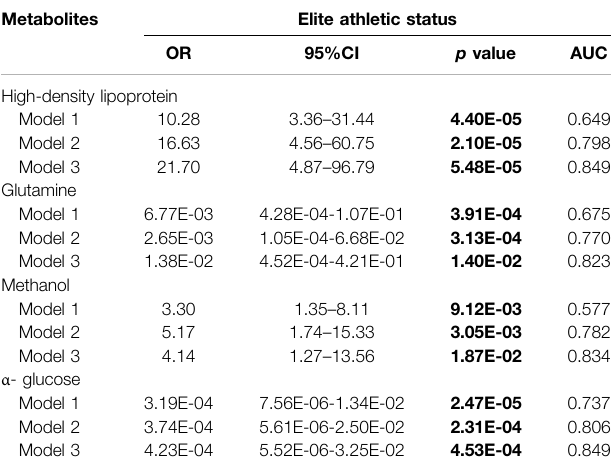
TABLE 4 | Association analysis between signi fi cant serum metabolites and athletic status in